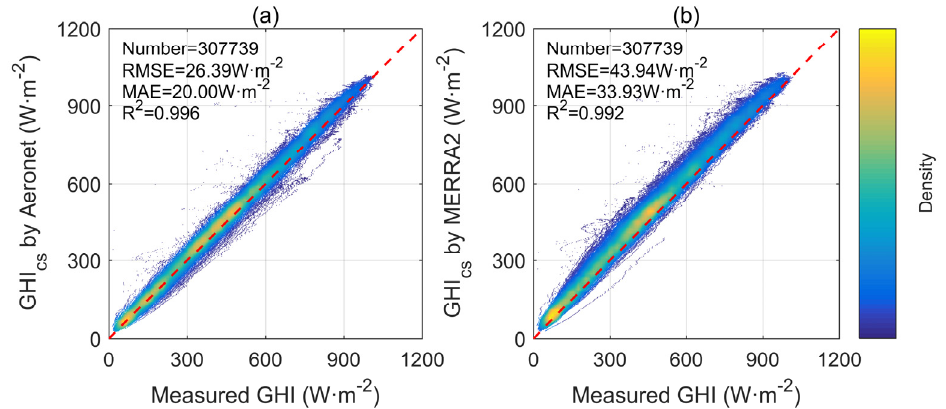
Figure 2. Colored scatter plots of measured clear-sky GHI and REST2-calculated GHI cs by ( a ) AERONET data and ( b ) MERRA-2 data. The color bar indicates the frequency of match, and the dashed red line indicates the 1:1 line.